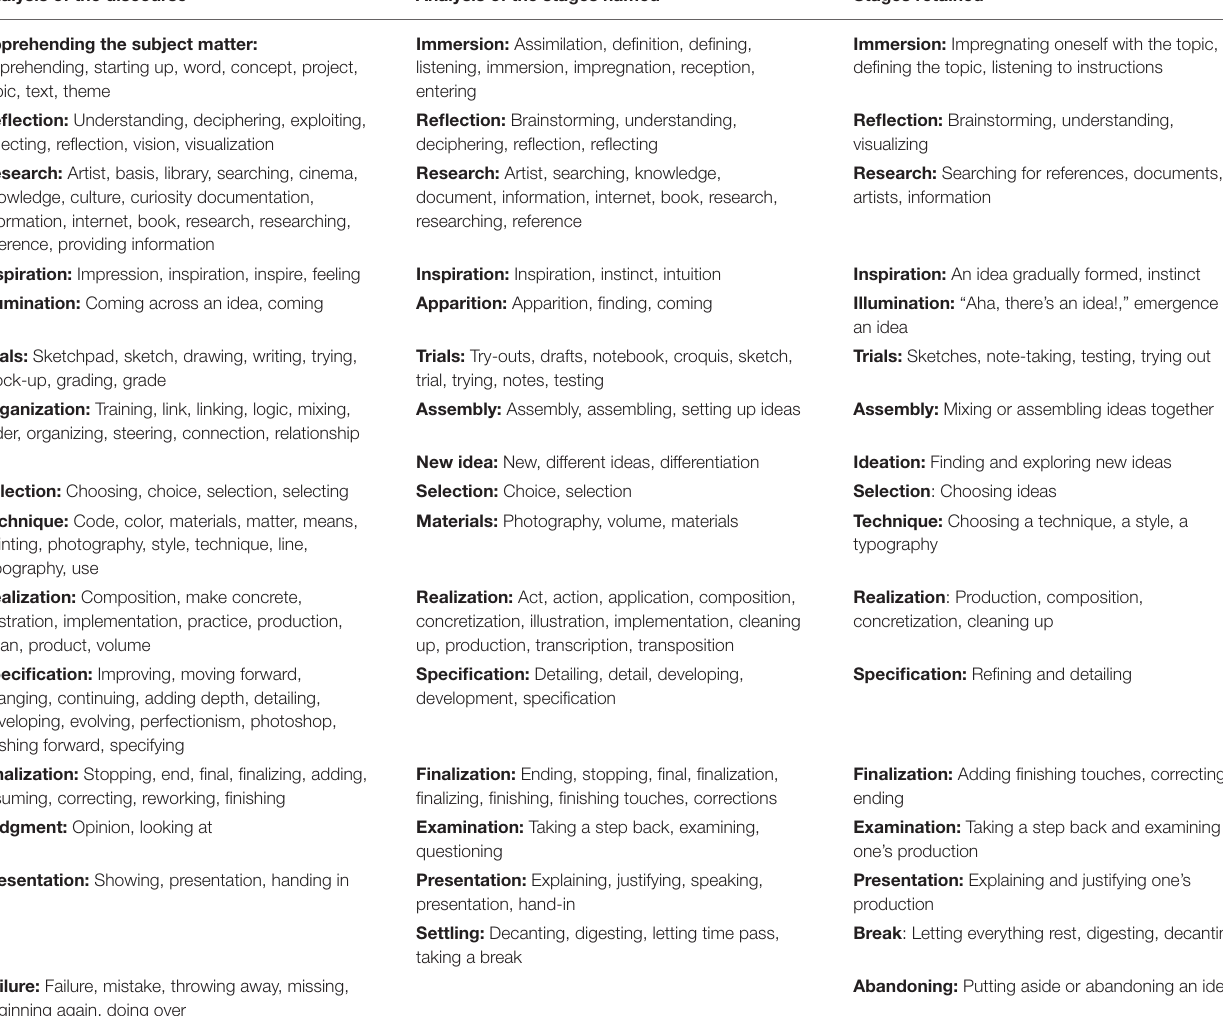
TABLE 4 | Confrontation between the two analyses. Analysis of the discourse Analysis of the stages named Stages